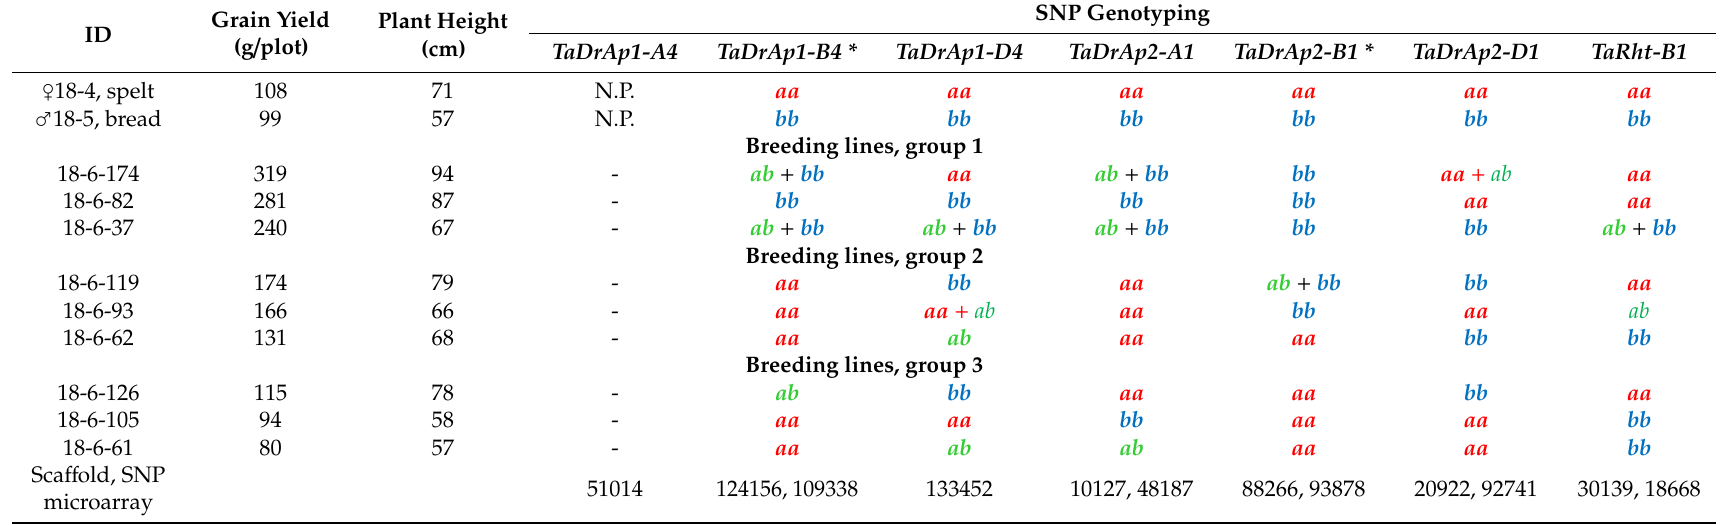
Table 2. Phenotypic evaluation for grain yield and plant height, and summary of genotyping scores from the 40K SNP microarray analysis, based on the sca ff olds, for the parents and nine selected breeding lines from the segregating population of interspecies cross No. 18-6. Breeding lines were arranged in three groups with high, moderate, and low yield of hulled seeds based on significant di ff erences between groups ( p < 0.05) at harvest in Northern Kazakhstan in 2020. Significant di ff erences for genotyping of breeding lines among the three groups ( p < 0.05) are indicated by asterisks (*) using Mann–Whitney non-parametric U-test with n = 2 in each genotype. Homozygote genotypes are indicated as ‘ aa ’ in red and ‘ bb ’ in blue, according to maternal and paternal genotypes, respectively, while heterozygotes ‘ ab ’ are indicated in green. Admixed lines are indicated as a mixture of two genotypes. N.P., non-polymorphic SNP markers